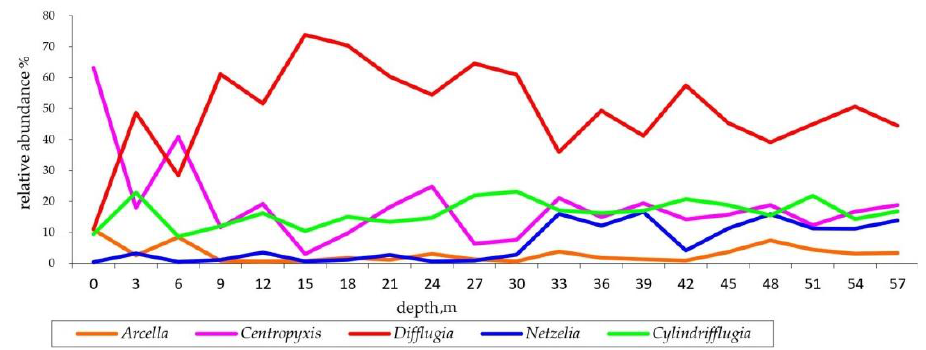
Figure 7. Relative abundance (%) of the genus Arcella , Centropyxis , Difflugia, Netzelia and Cylindrifflugia along the depth gradient.